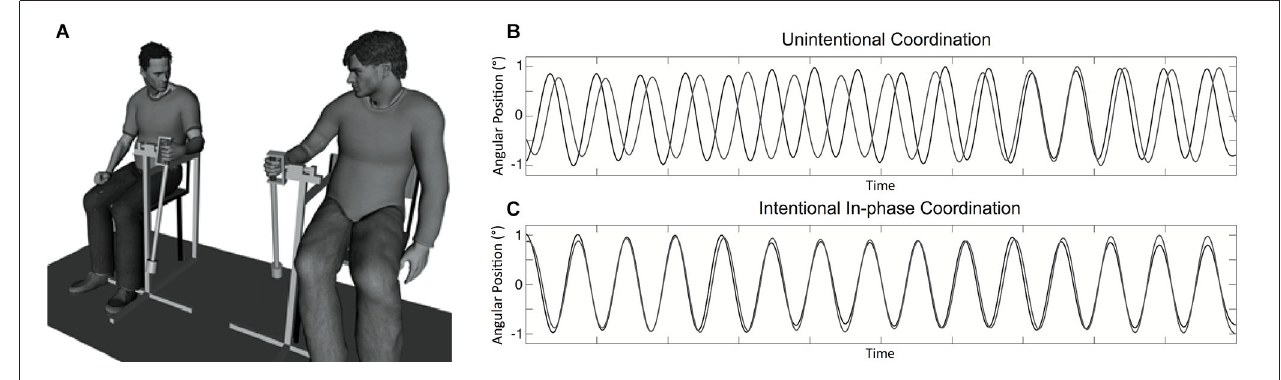
synchronization over time toward in-phase and anti-phase patterns. Panel (C) represents a time series typically collected when participants had to synchronize their movements in an in-phase manner in the intentional coordination